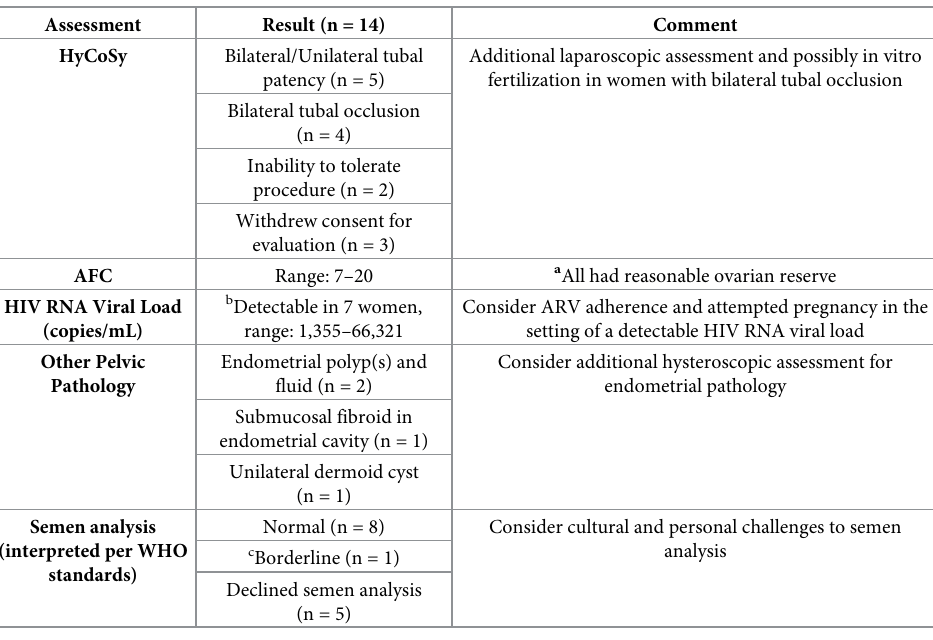
Table 2. Fertility evaluation